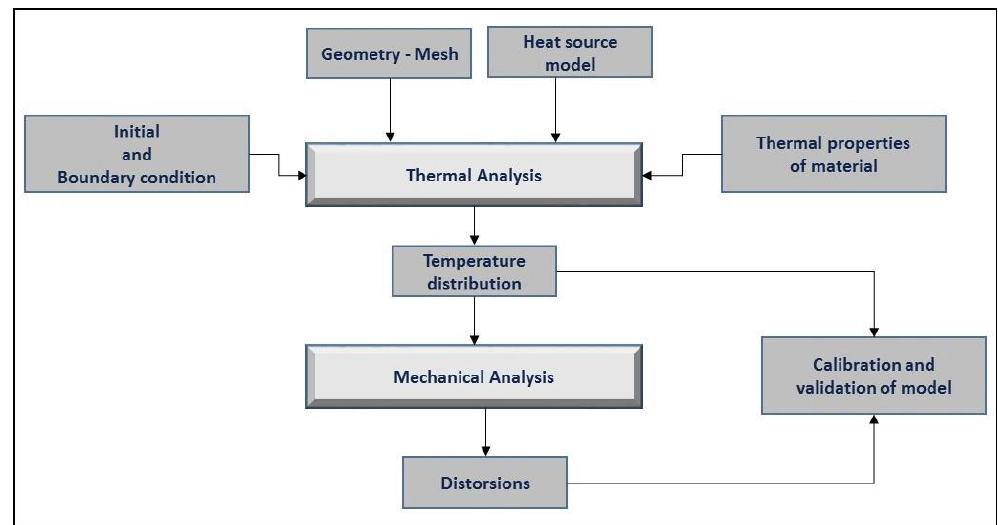
Figure 2. Flowchart of the simulation process.